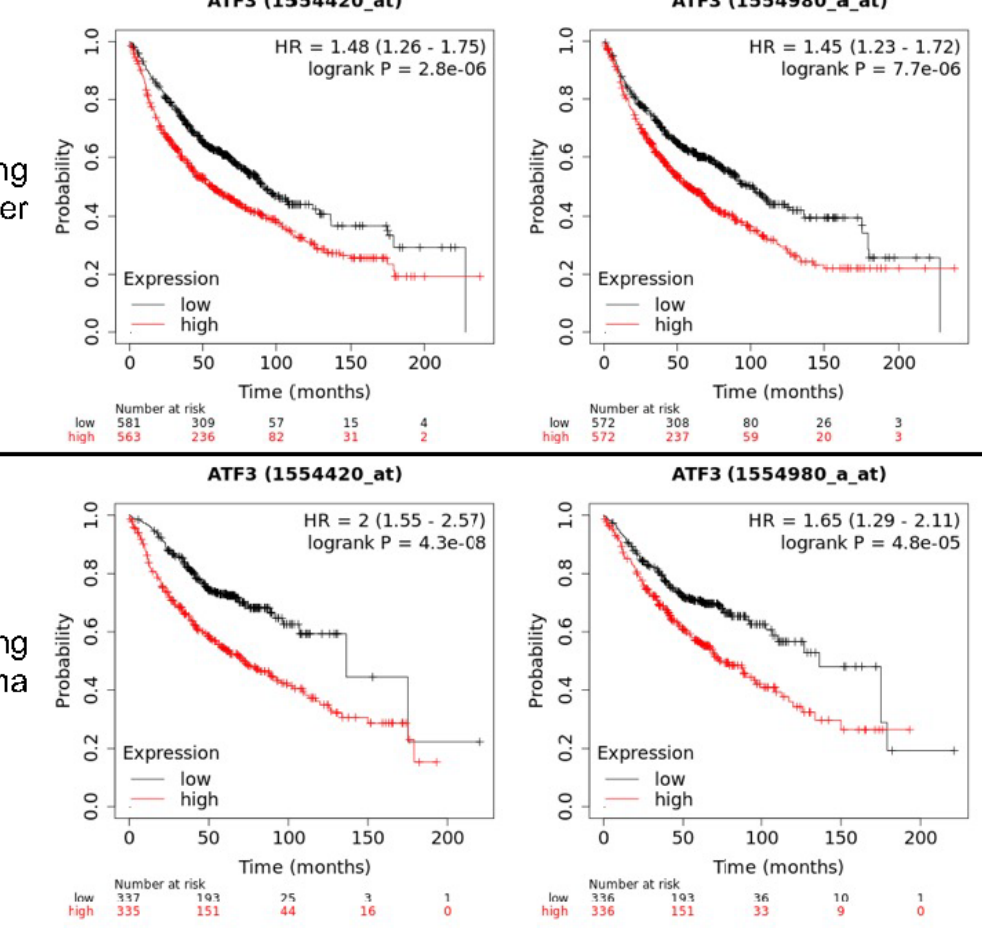
Figure 6. Increased expression of ATF3 predicates poorer survival of the lung cancer patients. Data are derived from Kaplan–Meier Plotter survival analysis of the total lung cancer patients ( top ) and the lung adenocarcinoma ( bottom ). Two different ATF3 gene probes were included in this analysis.